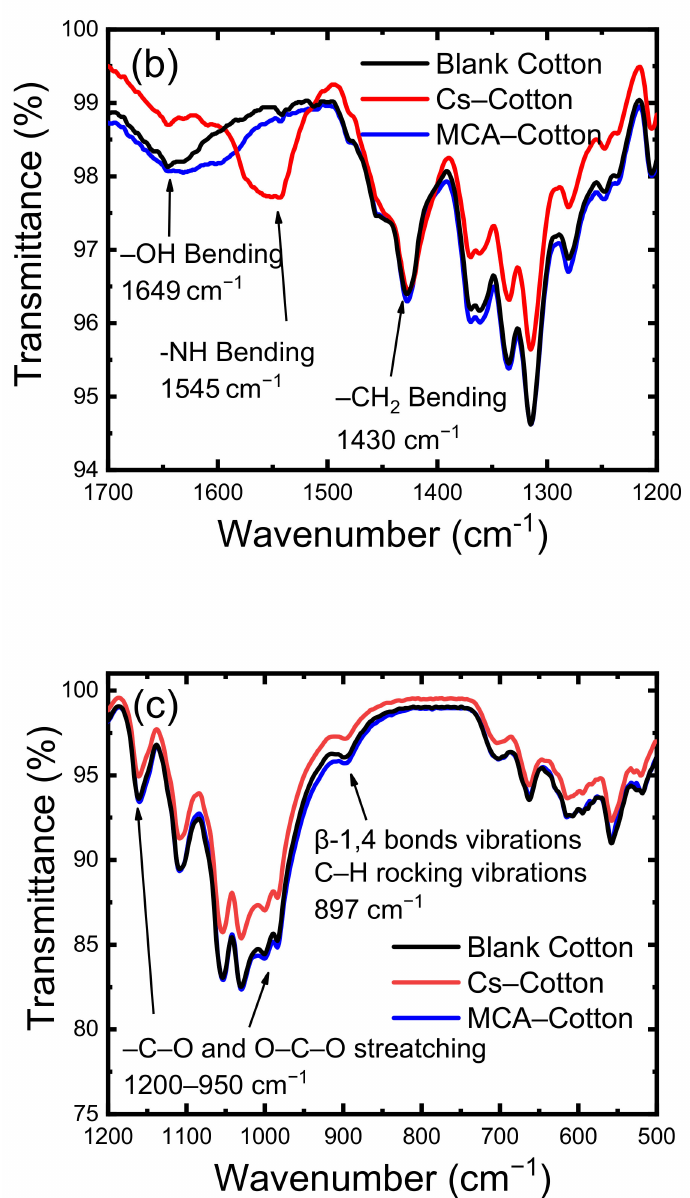
Figure 2. Fourier transform-infrared (FTIR) spectra of unmodified cotton gauze (blank), car- boxymethylated cotton gauze (MCA-Cotton), and cotton gauze modified with cationic chitosan (Cs-Cotton): ( a ) spectra from 3800 to 2700 cm − 1 , ( b ) spectra from 1700 to 1200 cm − 1 , and ( c ) spectra from 1200 to 500 cm − 1